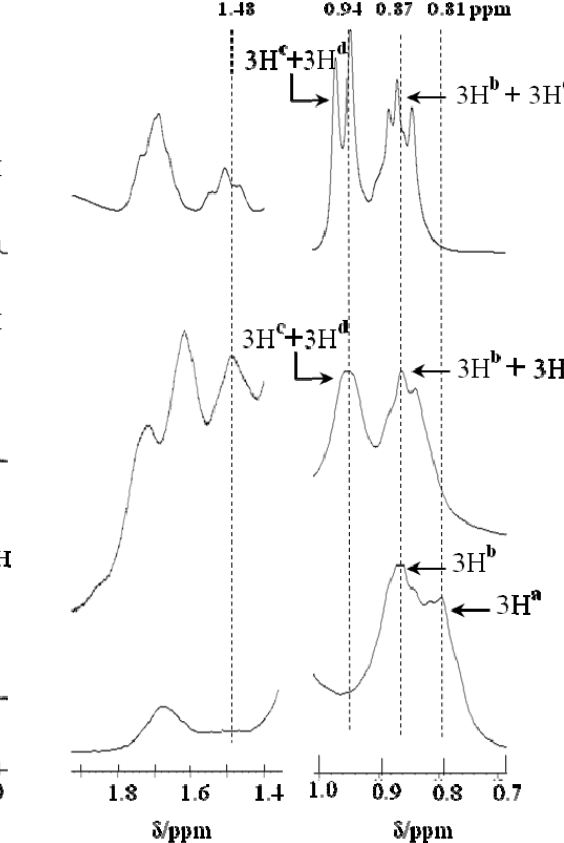
and poly( 1 ) and poly( re -1 ) in CDCl 3